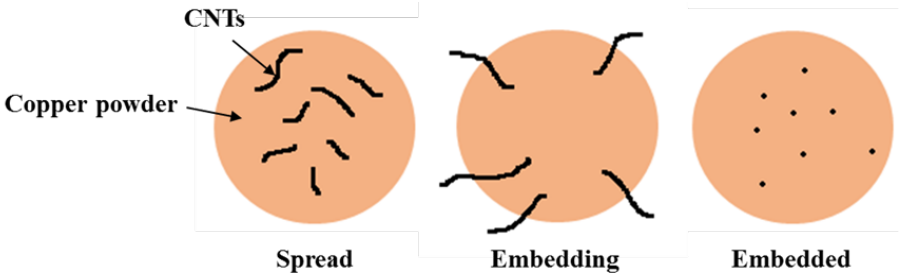
Figure 12. The schematic picture of mechanism of the CNT coating on the metal surface [20].